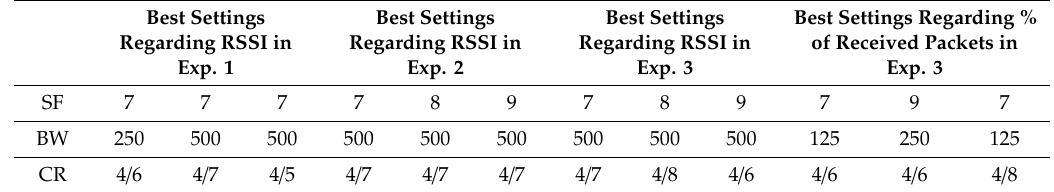
Table 4. Best settings in Experiments 1, 2, and